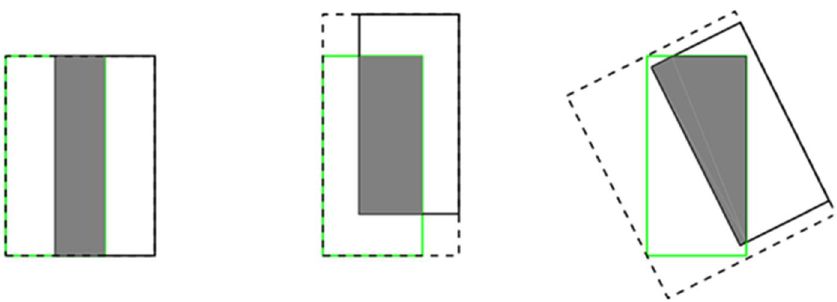
Figure 4. Three different crossover methods correspond to the same IOU value, value =